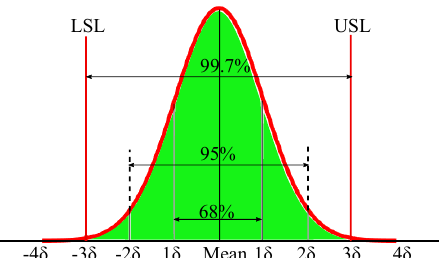
Figure 5. Gaussian Distribution of Manufacturing